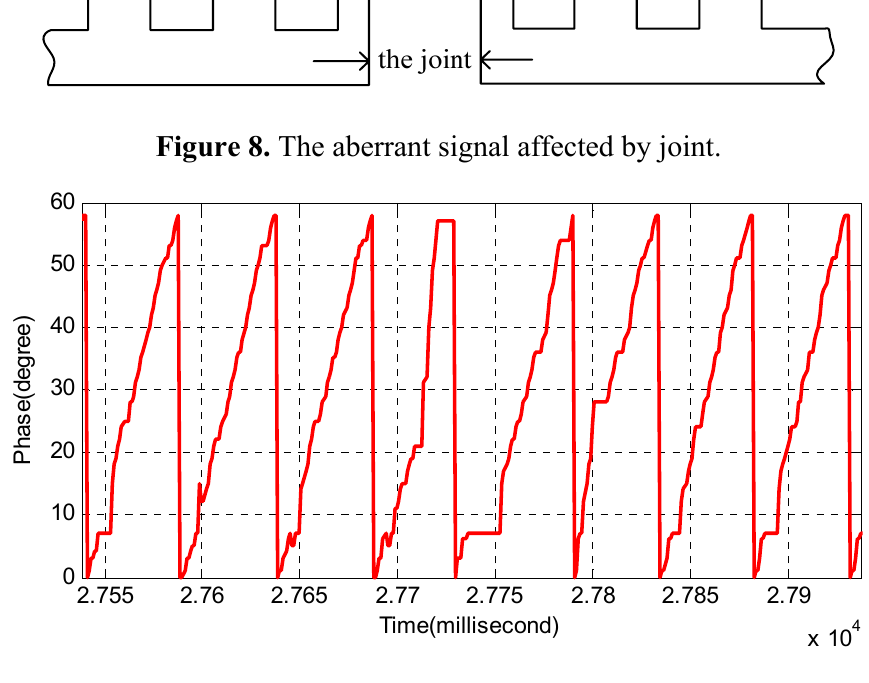
Figure 8. The aberrant signal affected by